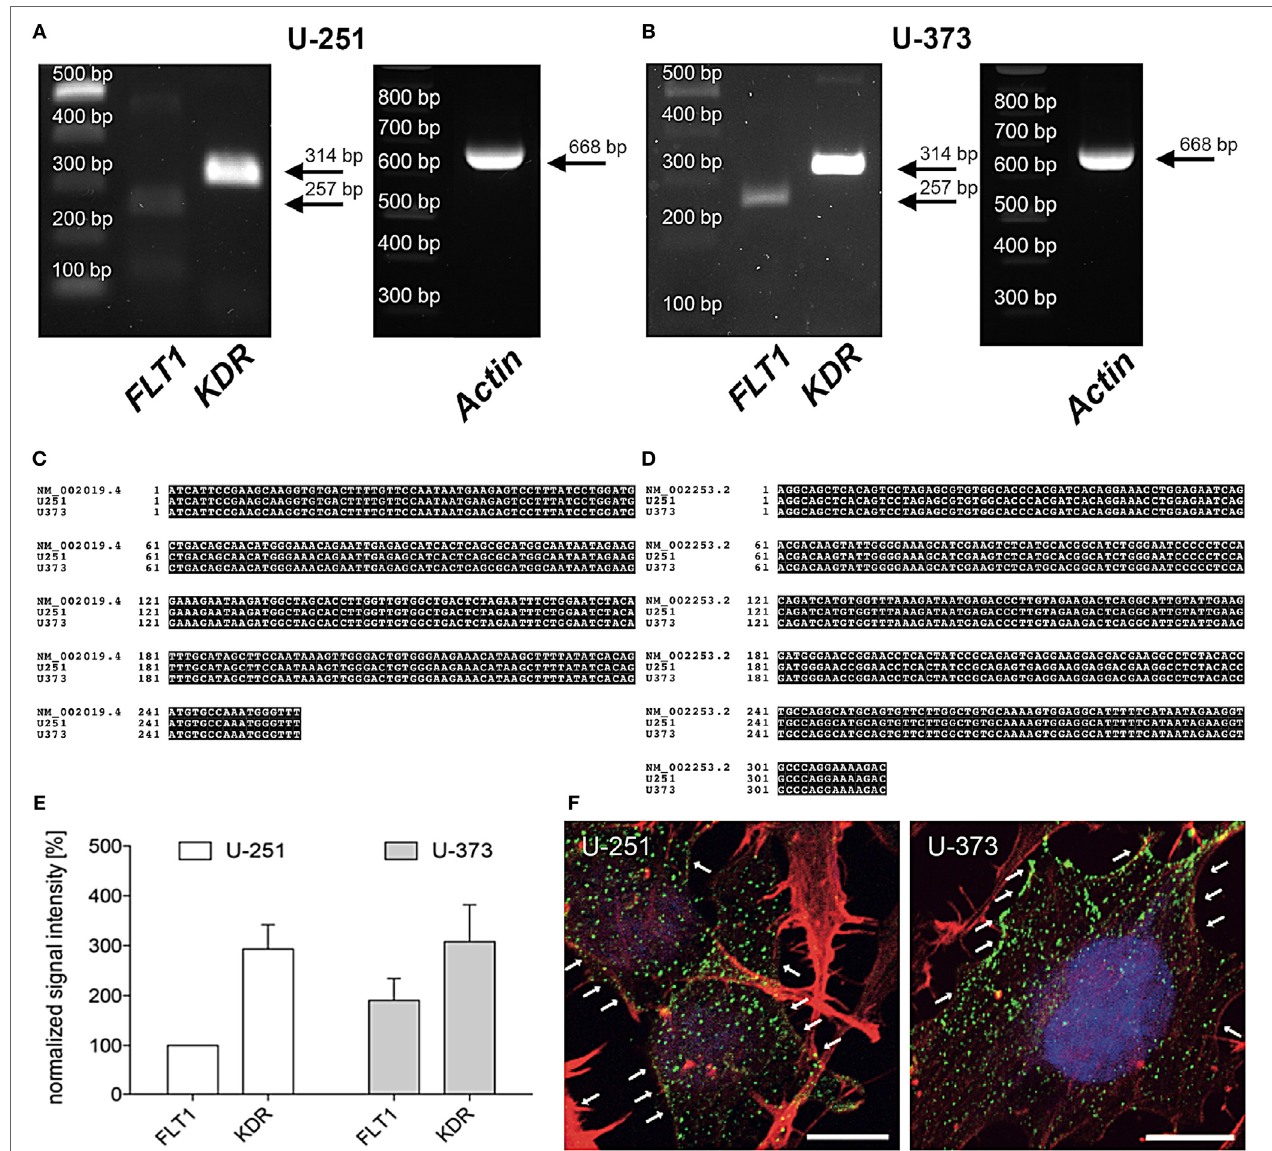
FigUre 1 | Expression of vascular endothelial growth factor (VEGF)-R2 ( KDR ) in U-251 and U-373 glioblastoma cell lines. (a,B) VEGF-R1 ( FLT 1) as well as VEGF-R2 ( KDR) are expressed in both cell lines U-251 (a) and U-373 (B) . β -Actin was used as housekeeping gene. PCR products were isolated and confirmed by DNA sequencing. (c,D) Sequence of amplified PCR product for FLT1 (c) and KDR (D) matches their specific database entries ( FLT1 – NM_002019.4; KDR – NM_002253.2) and were proven to be unique in human glioblastoma cell lines U-251 as well as in U-373 by comparison with a database (Blast 2.2, U.S. National Centre for Biotechnology Information, Bethesda, MD, USA) (e) . Semi-quantitative analysis of gene expression normalized to β -Actin and compared to the expression of U-251-FLT (100%). Data are shown as mean ± SEM. n = 3. (F) Both glioblastoma multiforme cell lines express VEGF-R2 (green dots, arrows) in the cytoplasm as well as along the cell membrane. Counterstaining of the actin cytoskeleton is given in red as well as cell nuclei staining with DAPI in blue. Scale bars: 10